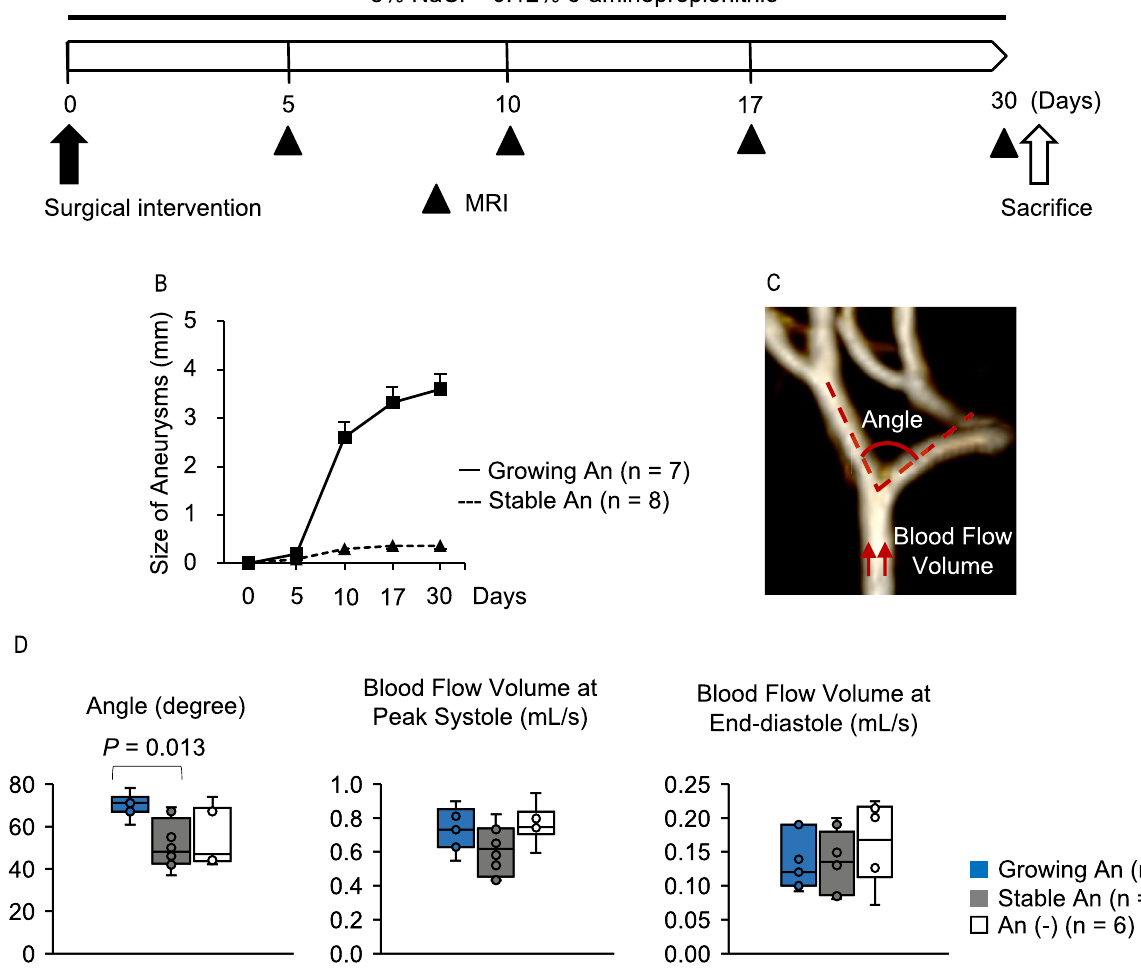
(Fig. 3D). The box-and-whisker plots showed a threshold of 61° in the bifurcation angle for the growing aneu- rysms (Fig. 3D). The bifurcation angles in the no aneurysm group (median, 47°; IQR, 45°–62°) were similar to those in the stable group (Fig. 3D).